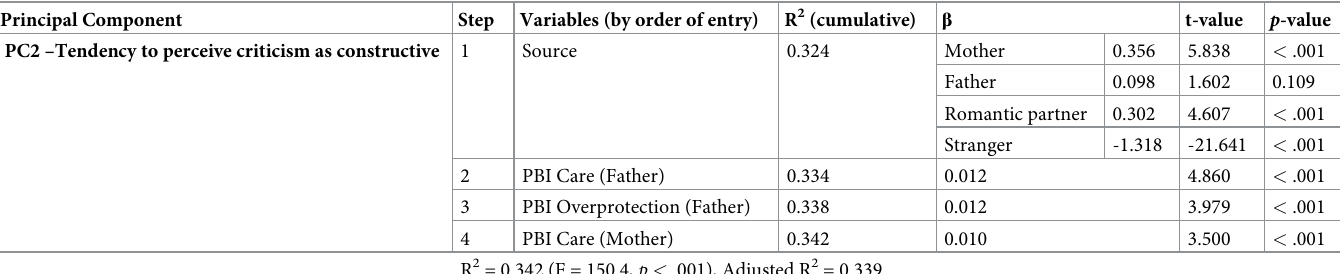
Table 4. Table of final model in stepwise regression for PC2. Principal